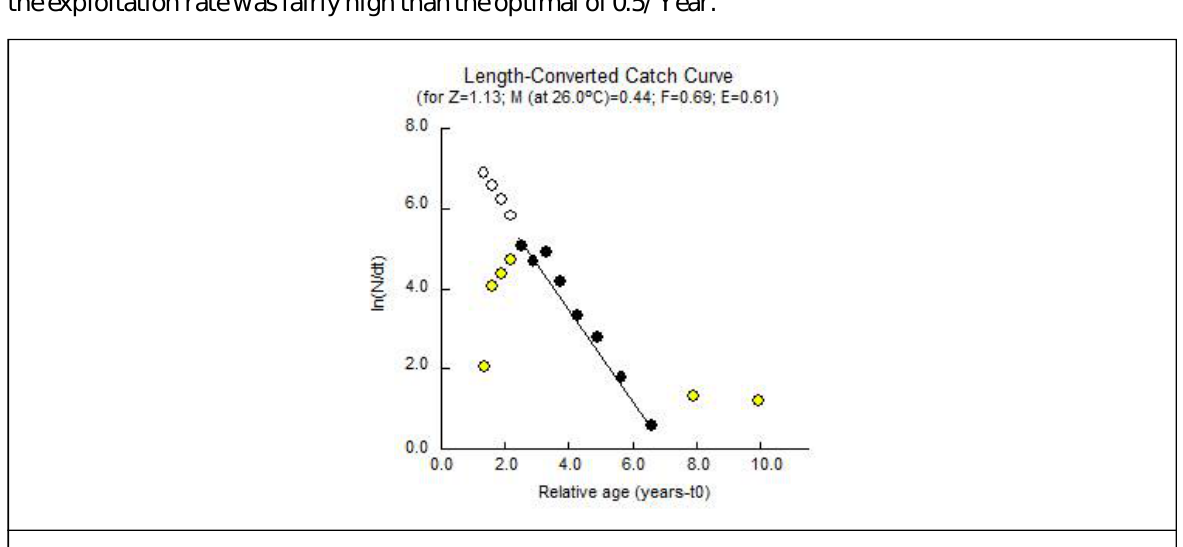
Figure 4: Length –Converted Catch Curve showing mortality and relative age for Xiphias gladius in the Kenya coastal waters